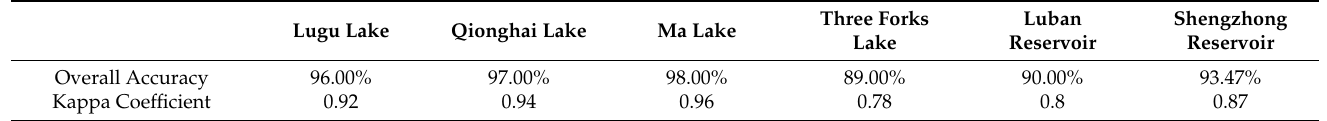
Table 3. Results of validating water body extraction accuracy with the Global Surface Water dataset.